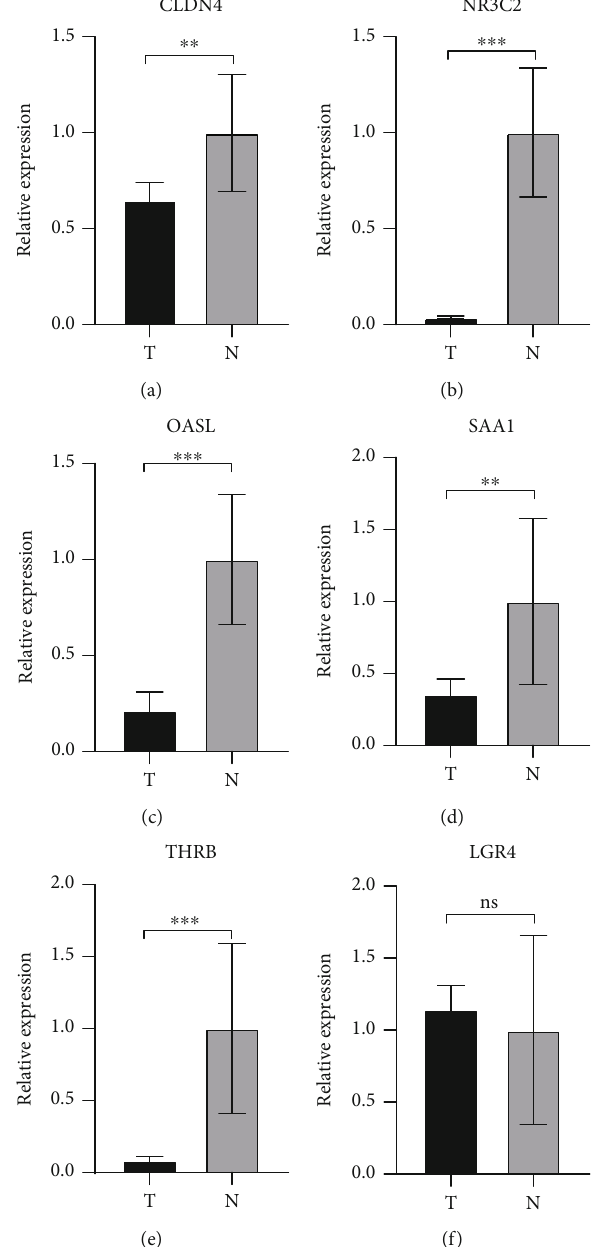
Figure 8: The expressions of some genes used to construct IGRPM in early KIRC and adjacent normal tissues by RT-qPCR. The relative expressions of CLDN4 (a), NR3C2 (b), OASL (c), SAA1 (d), THRB (e), and LGR4 (f) in early KIRC compared with adjacent normal tissues. T: KIRC tissues; N: adjacent normal tissues; ∗ p < 0 : 05 , ∗∗ p < 0 : 01 , and ∗∗∗ p < 0 : 001 ; ns: the di ff erence was no statistically signi fi